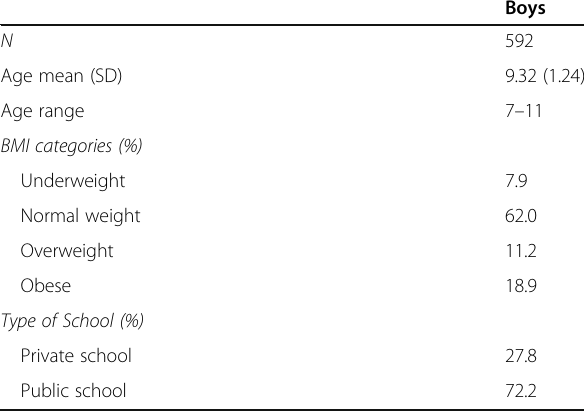
Table 5 Demographic information for Brazilian